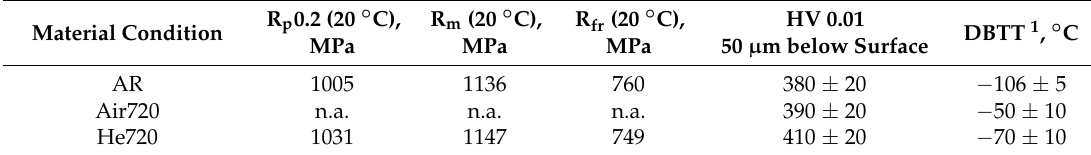
Table 3. Characteristic mechanical behavior parameters measured for the ODS